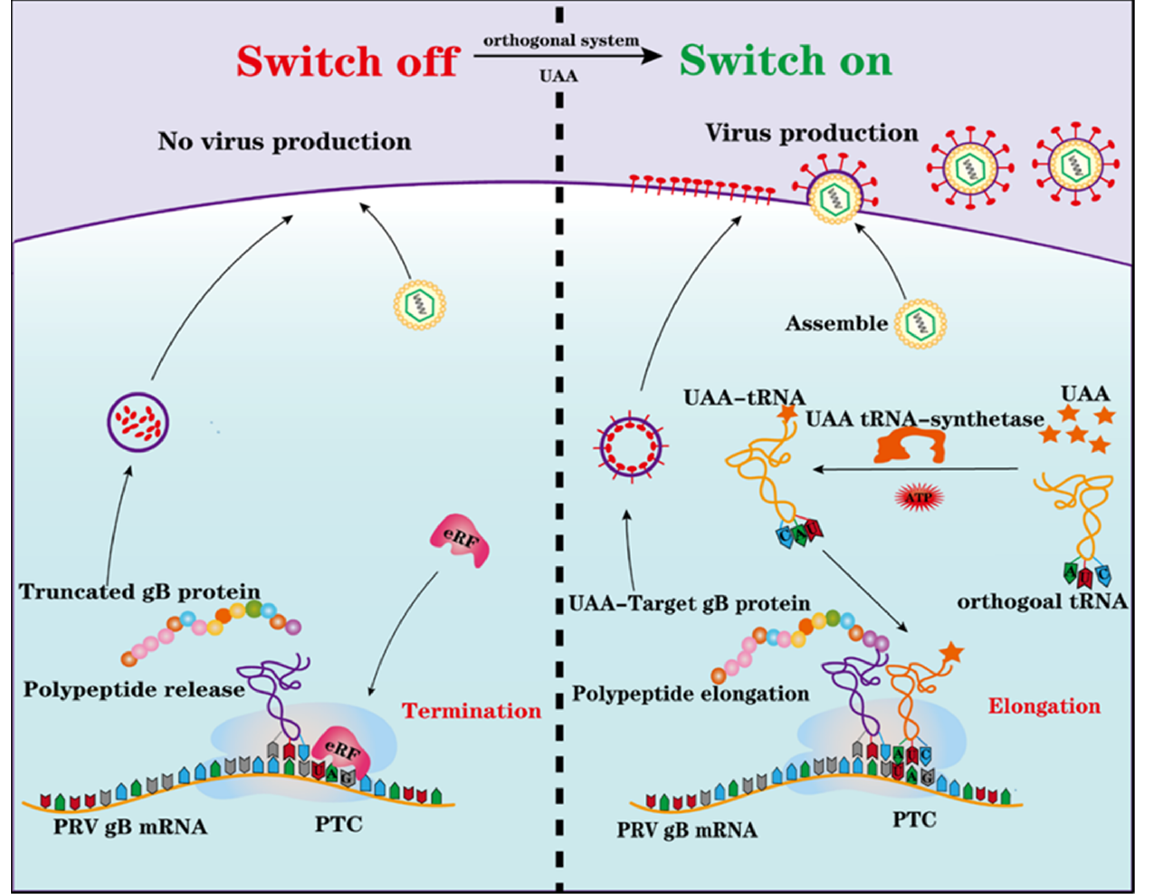
Figure 1. Schematic representation of the construction of PTC harboring PRV via genetic code expansion. PTC harboring PRV failed to replicate in normal cells ( Left ) and can replicate in cells with orthogonal translation machinery system ( Right ). UAA, unnatural amino acid. PTC, premature termination codon.